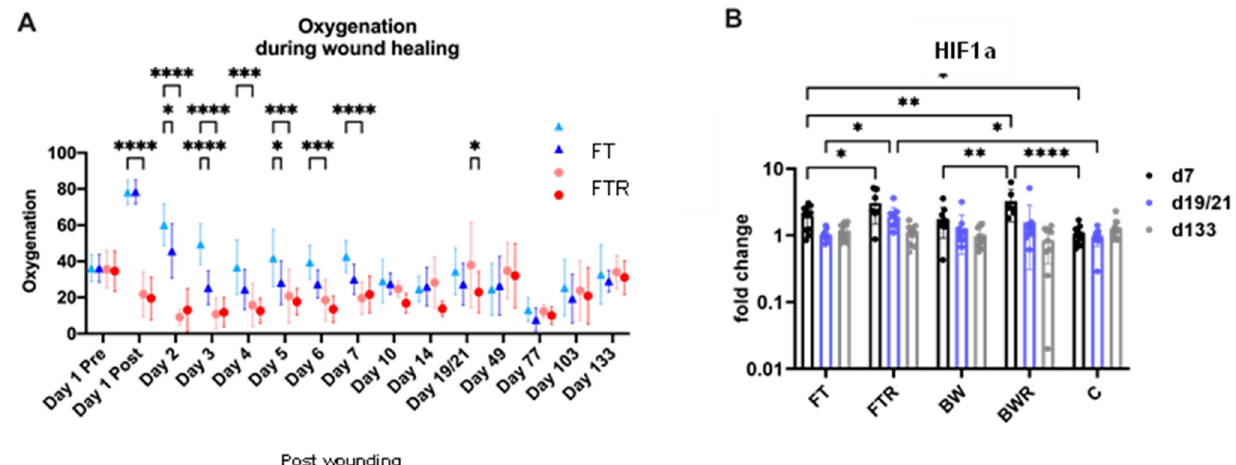
Figure 2. Burn injury and resiquimod-induced inflammation in full-thickness wounds result in relative hypoxia. ( A ) Oxygenation levels in different wound types examined by hyperspectral imaging showed hyperoxygenation of full-thickness wounds immediately after wounding with resiquimod-induced full-thickness wounds rapidly reaching the relative hypoxia levels of burn wounds. Oxygenation levels converged 10 days after wounding. ( B ) Analysis of HIF1a expression levels in wound biopsies showed higher expression in resiquimod-induced wounds than in non-induced full thickness wounds at day 7, and the difference between induced and non-induced wounds persisted until day 21. Data are presented as mean ± SD. Statistical significance was determined using the two-way-ANOVA test and a Tukey post hoc test. * = p < 0.05, ** = p < 0.01, *** = p < 0.001, **** = p < 0.0001, FT = Full-thickness wound, FTR = Full-thickness wound with resiquimod, BW = Burn wound, BWR = Burn wound with resiquimod, C = Control biopsies.